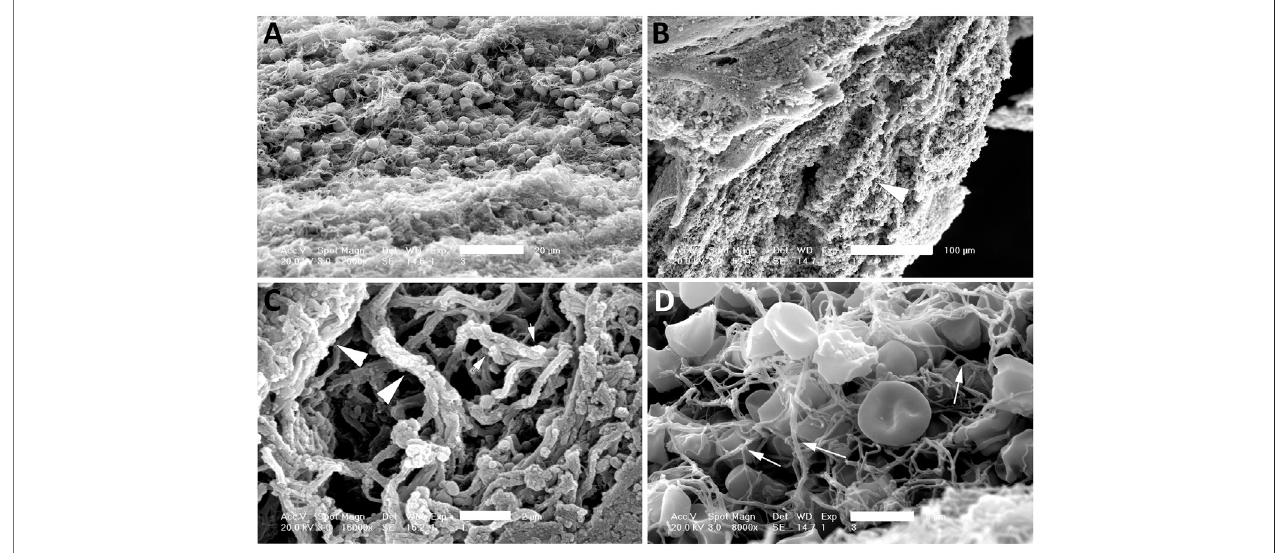
FIGURE 1 | SEM of clots from AIS patients. Clots were processed for SEM indicating the presence of red blood cells (A and D) , fi brin (arrow heads, B and C), histones (short arrows, C) and interconnected fi bers (arrows, D) consistent with the presence of NETs in the clots of these patients. Scale bars: (A) 20 μ m, (B) 100 μ m, (C) 2 μ m, (D) 5 μ